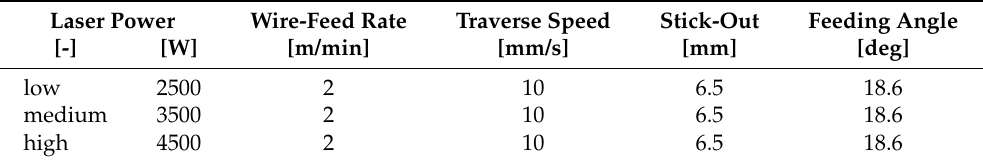
Table 1. Processing